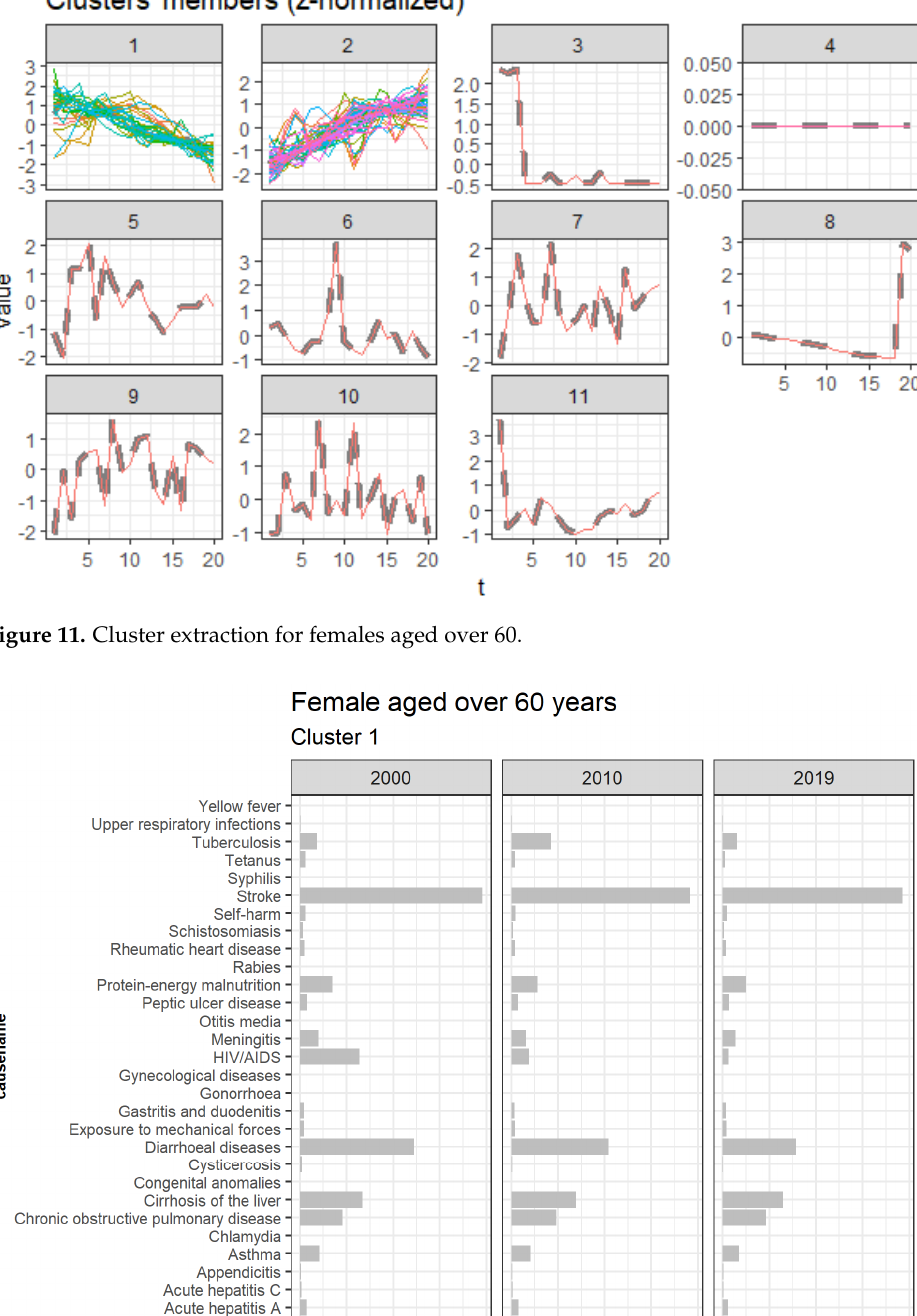
Figure 13. Increasing trend causes among older females in cluster 2 for 2000, 2010, and 2019. 3.5.3. Males Aged 20 to 60 Regarding the males aged 20 to 60, cluster 1 represents clusters trending downwards while cluster 4 combines upward trending and recently declining trends with a trend change observed in 2010, as shown in Figure 14. Cluster 2, 5, 6, 7, 8, 9, and 10 are outliers,